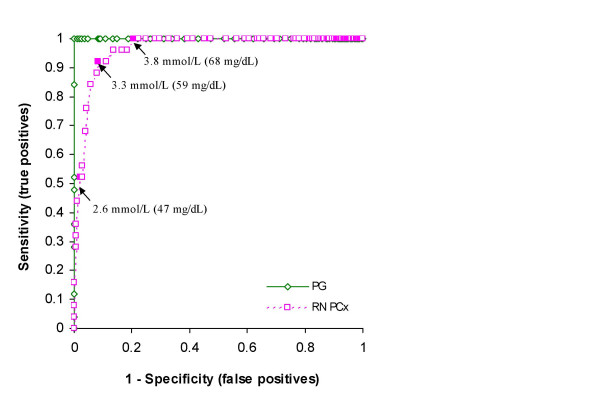
ROC curve for neonatal hypoglycemia. ROC curve for plasma glucose measured on the Vitros 950 (PG) and whole blood glucose measured at the bedside with the PCx glucose meter (RN PCx). The arrows indicate the PCx screening cut off values for hypoglycemia of 2.6 mmol/L (suggested hypoglycemic screening threshold value for PG), 3.3 mmol/l (highest accuracy) and 3.8 mmol/L (highest sensitivity). The diagonal line indicates no discrimination.